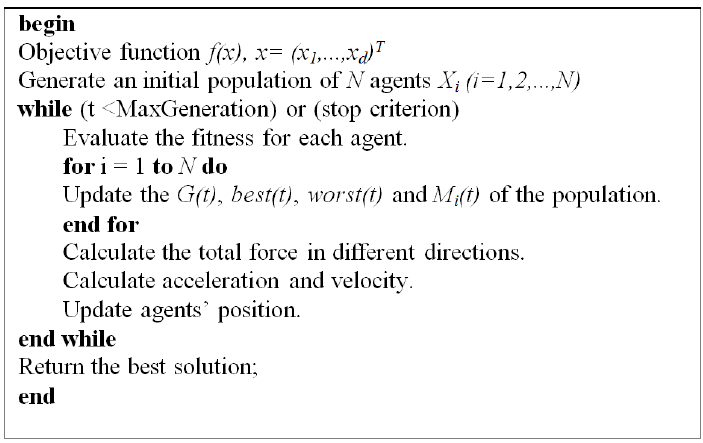
Figure 1. Pseudo code of the Gravitational Search Algorithm (GSA).